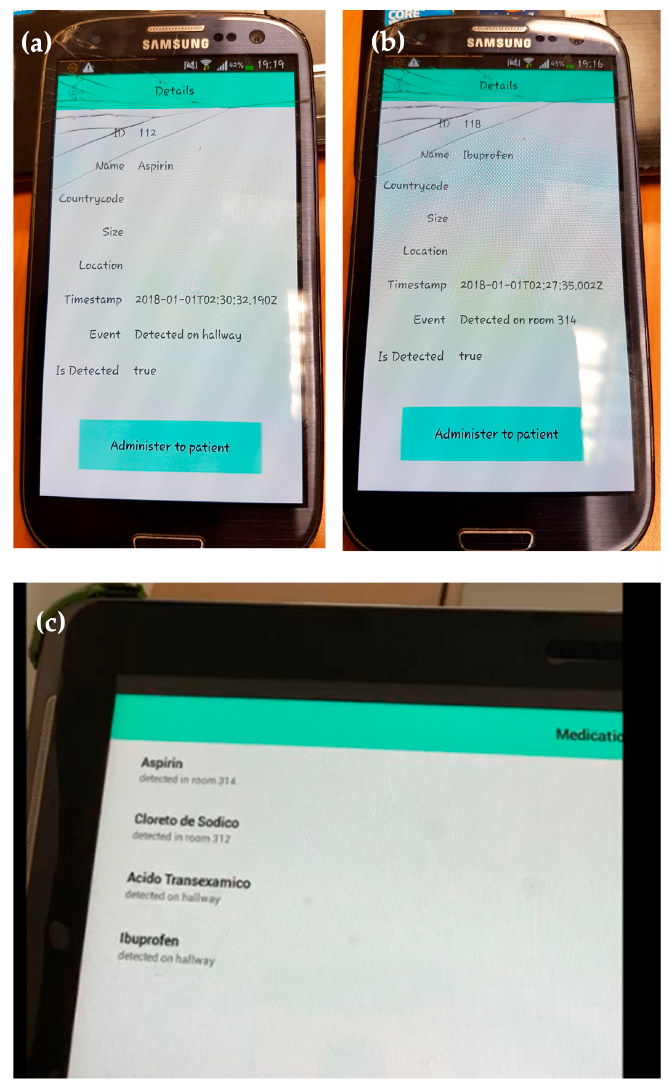
Figure 9. Screenshots of the mobile application implemented to show real-time information of the tagged assets detected by the RFID system. ( a , b ) Mobile application installed in a smartphone, showing detailed information about the item detected. ( c ) Mobile application installed in a tablet, showing the list of detected items and where they are.